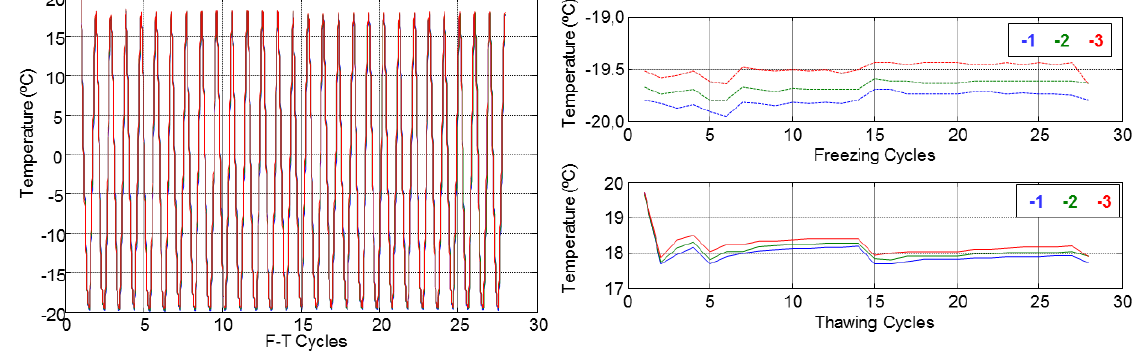
Figure 11. Temperature inside specimen